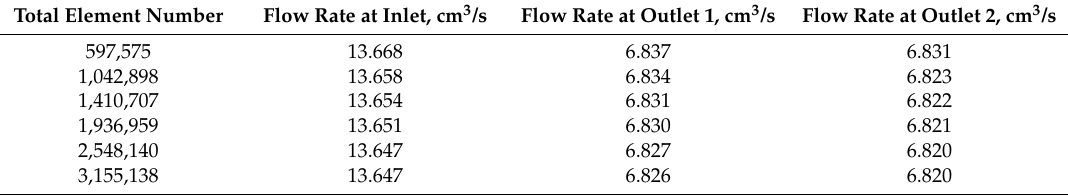
Table 1. Mesh sensitivity study for stent computational fluid dynamics (CFD) model.